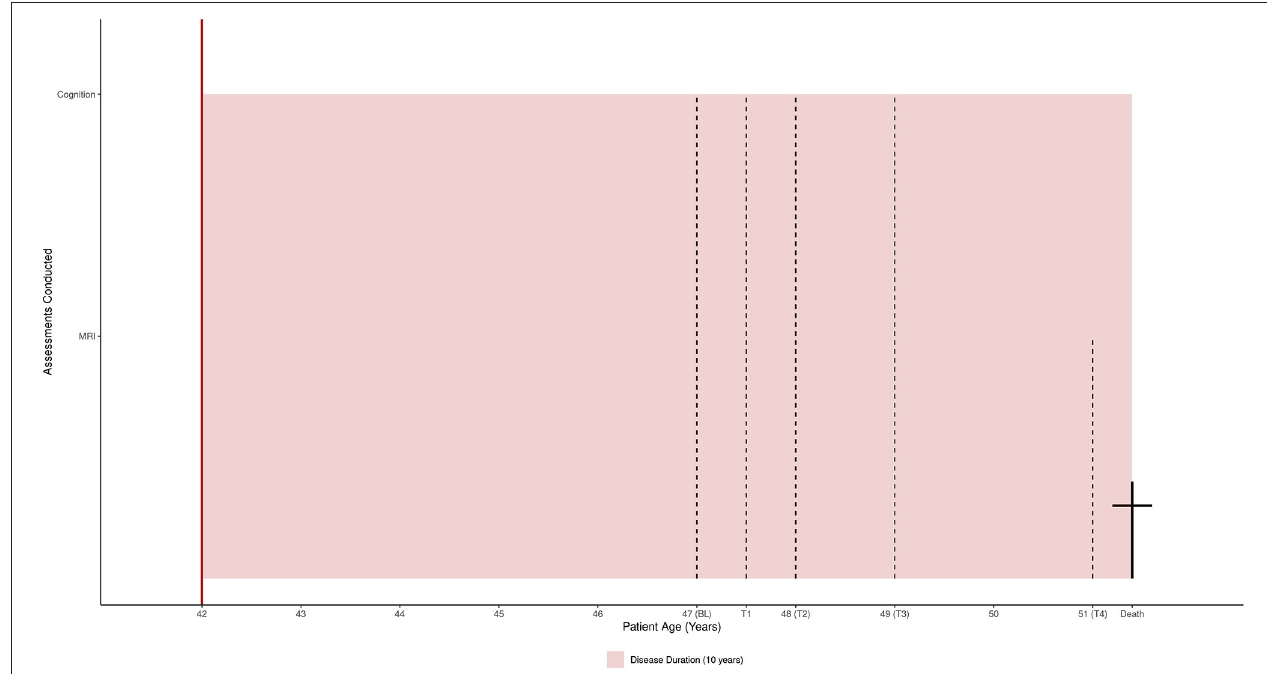
FIGURE 1 | The patient’s assessments and 10-year disease duration mapped to his life span (51